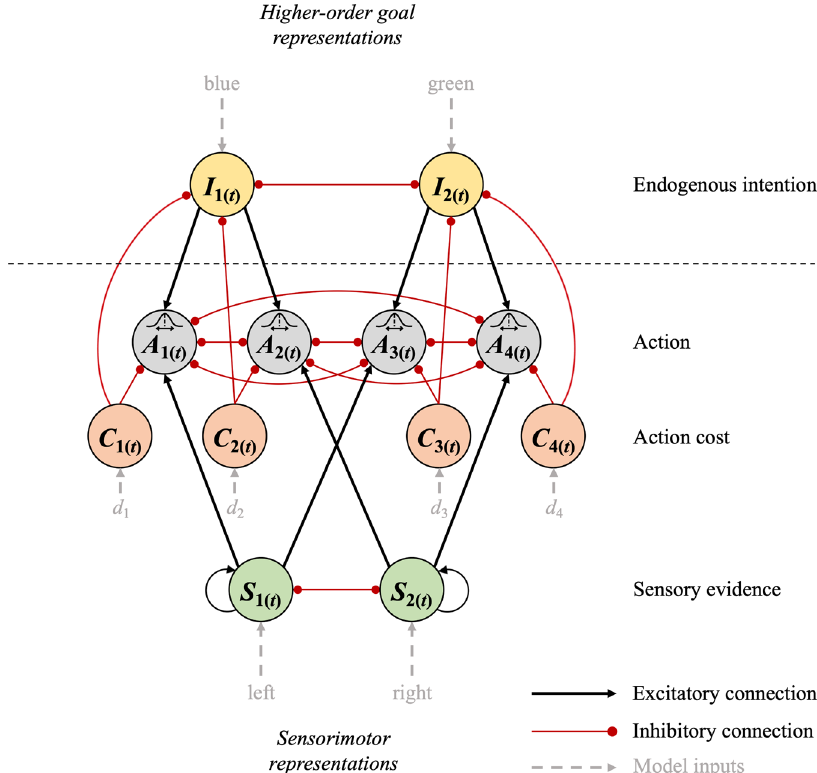
Fig. 5 Hierarchical Attractor Network Model of Changes of Mind in voluntary action. The network consists of 12 neural nodes that encode different pieces of information. Nodes are connected through excitatory (black) or inhibitory (red) connections. The action nodes A 1 – A 4 compete against each other to determine which one of the four choice targets is selected. This competition takes into account information about ( 1 ) endogenous intentions (blue/ green represented by nodes I 1 and I 2 ), ( 2 ) sensory information (left/right encoded by sensory nodes S 1 and S 2 ) and action costs ( C 1 – C 4 ) that depend on the distance d to each target location. Intention nodes are represented on a hierarchically higher level than sensorimotor nodes, allowing for top-down regulation of the degree of variability in fi ring rates of the action nodes. All fi ring rates are updated continuously and can change dynamically. Hence, CoM can occur when one action node crosses the threshold for movement execution fi rst, but later on, another action wins the competition. Different types of CoM can be dissociated based on which action the network switches to when a decision reversal occurs (e.g., perceptual CoM: switch from A 1 to A 2 ; perceptual + intentional CoM: switch from A 1 to A 4